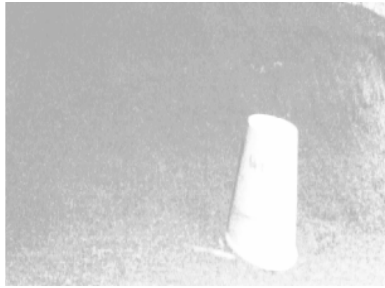
Figure 6. Disparity map in a simulated environment.